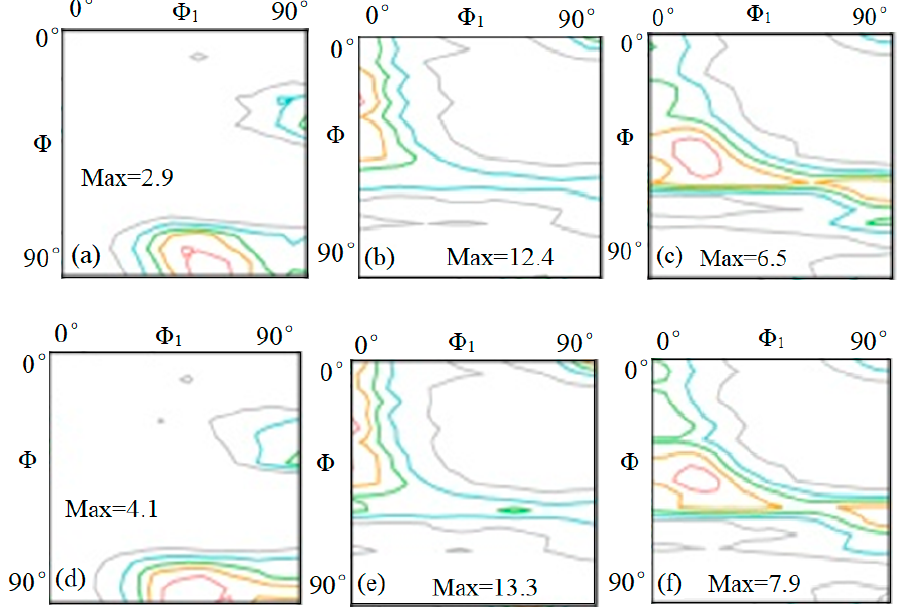
Figure 7. The ODF cross section ( Φ 2 = 45 ◦ ) in the rolling process. 1#: ( a ) HR, ( b ) CR, ( c ) CA. 2#: ( d ) HR, ( e ) CR, ( f ) CA.